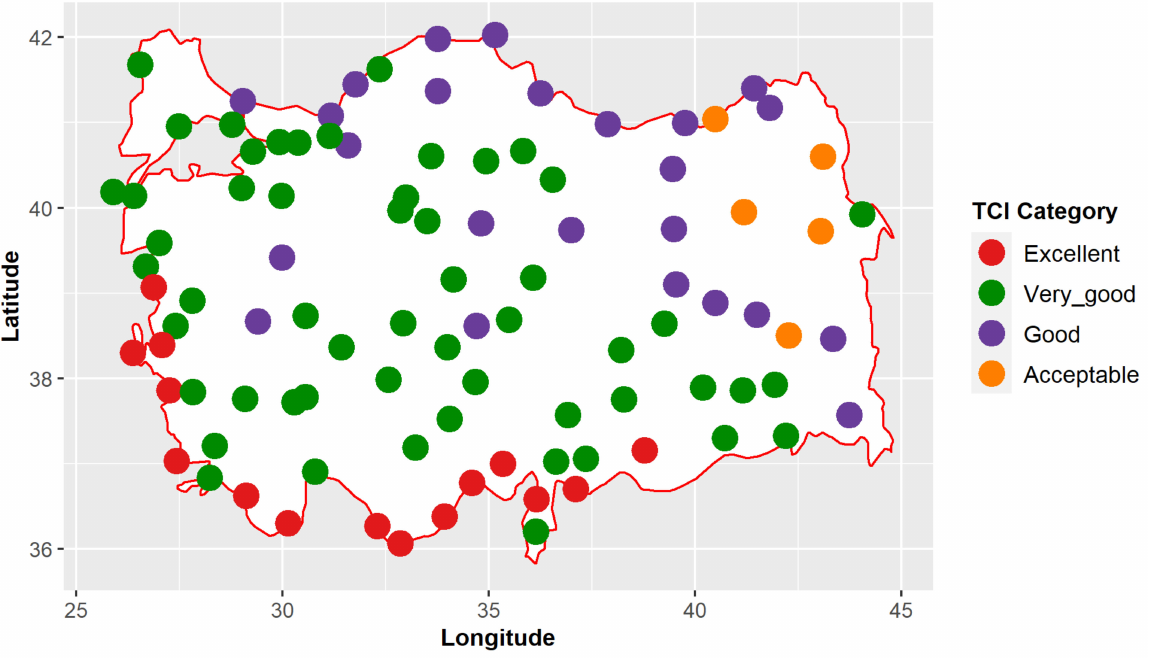
Figure 3. The TCI distribution for